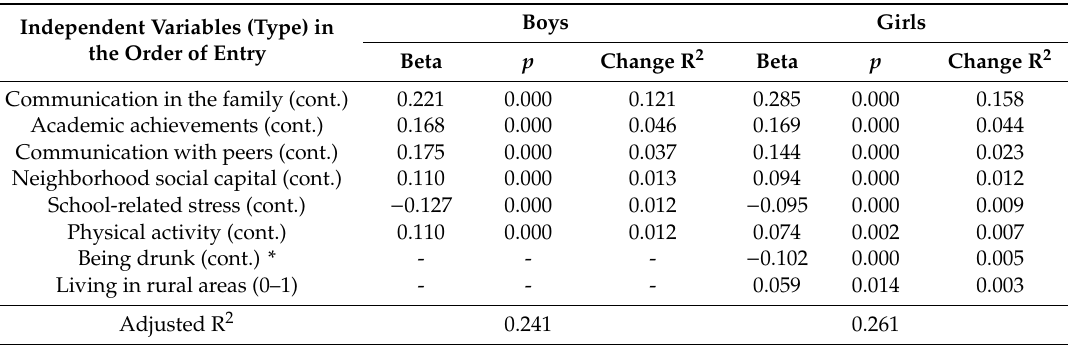
Table 4. Estimation gender-specific regression models with stepwise selection; dependent variable— standardized Positive Attitude Score